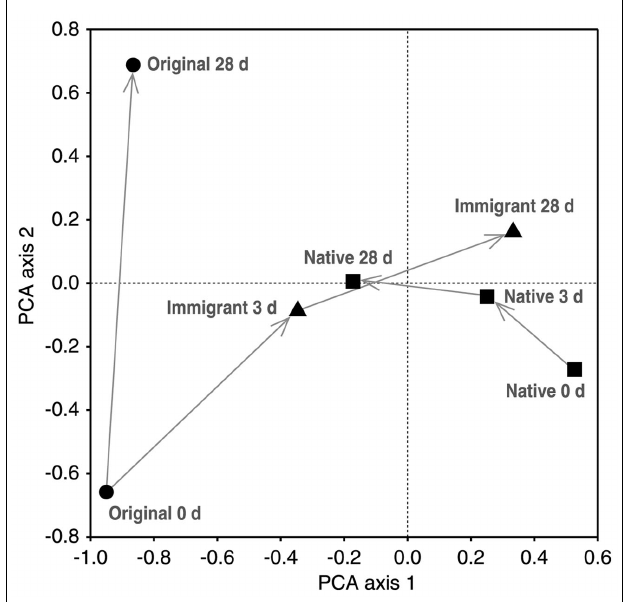
FIGURE 2 | Principal component analysis (PCA) of binary microarray data. Sample means from different sampling times in days (d) are showed [original 0days = original inactive moss ( n = 1), original 28days = original moss transplanted back to the original site ( n = 3), immigrant = original moss transplanted to the active flark sites ( n = 6), native = native mosses of the active flark sites ( n = 6)].The first and second PCA axes explain 25 and 11% of the compositional variation,